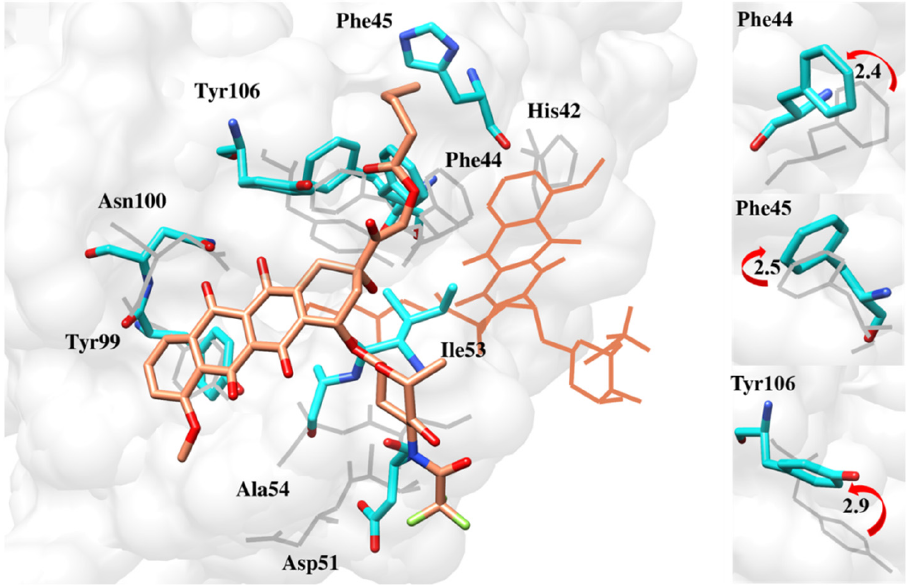
Figure 15. Deflection of Phe44, Phe45 and Tyr106 during MD simulation to accommodate ZINC28232750 deeper inside the pocket [17].